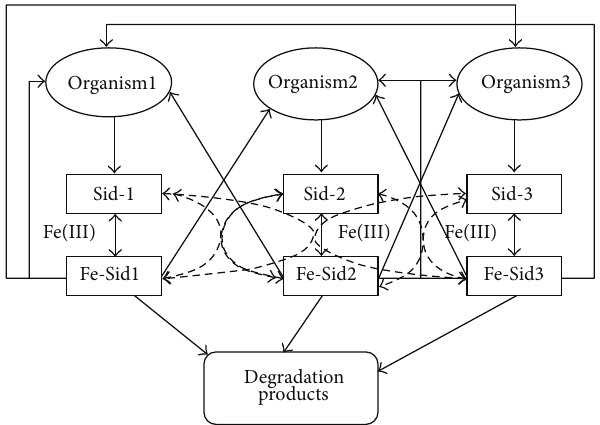
Figure1:Modelofsiderophoremediatedinteractionsbetweenthree organisms. The thick lines indicate transport by one organism of the Fe-Sid produced by the other organism. The dashed lines represent ligand exchange by which one Sid displaces another Sid chelating and Fe 3+ iron. Degradation pathways, including biological and chemical mechanisms, are represented by the thin black arrowed